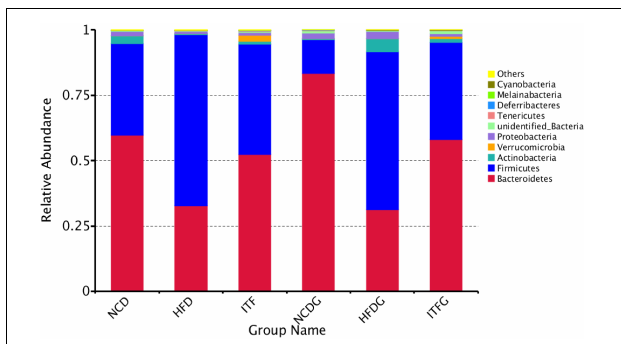
FIGURE 4 | Relative abundance of microbial species of the top 10 phyla in the feces of mice.